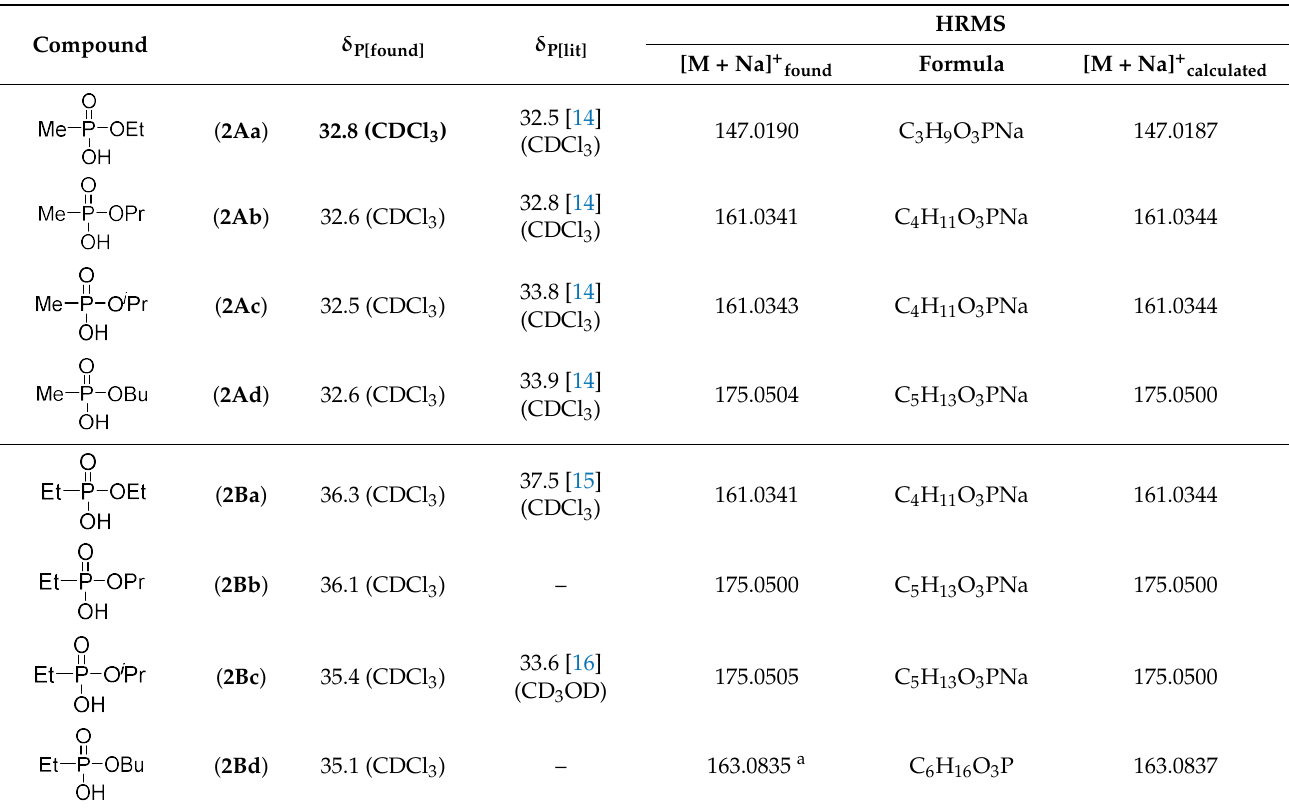
Table 7. Identification of the ester-acids ( 2A – D/a – d ).